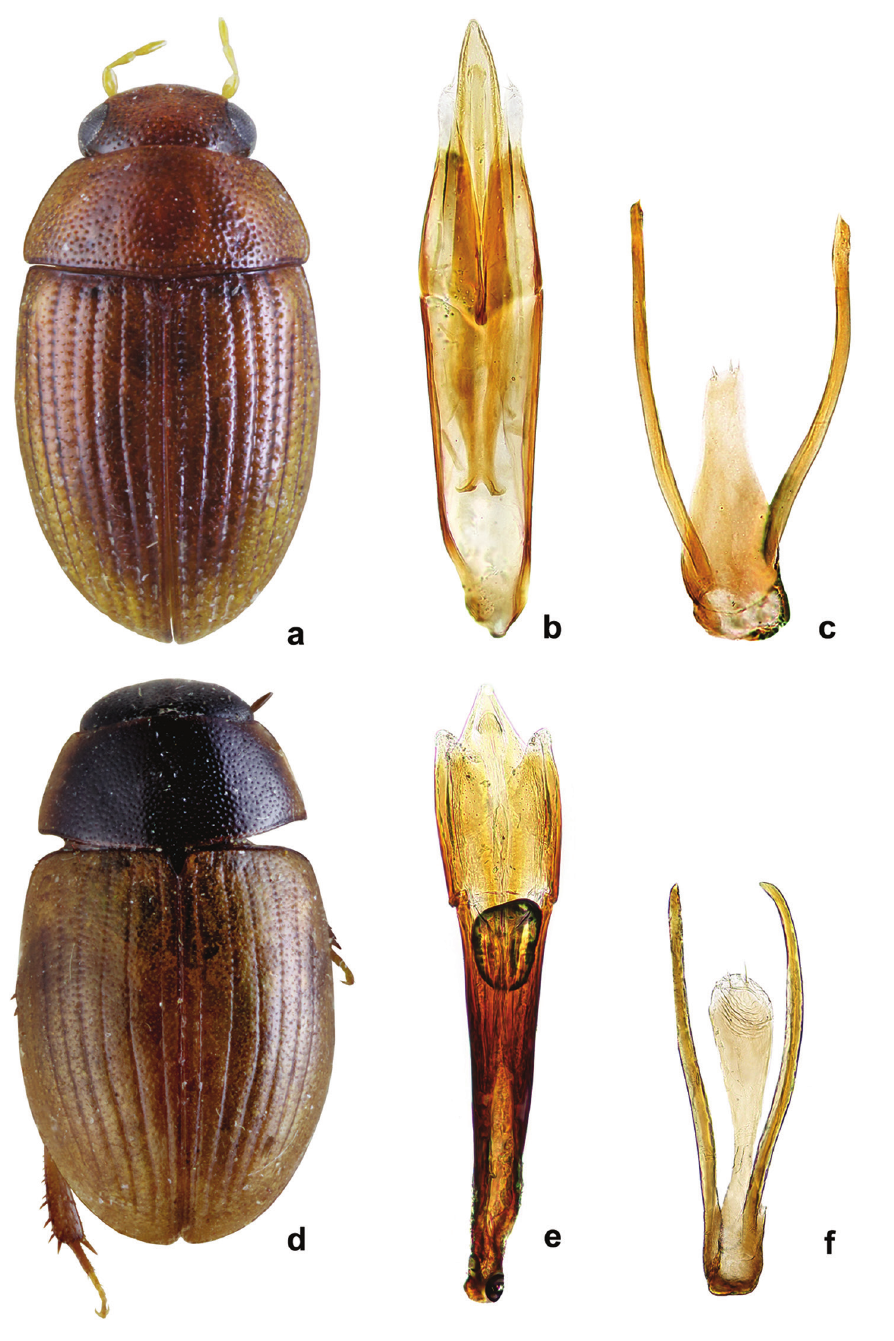
Figure 6. Cercyon (Acycreon) spp. a–c Cercyon (Acycreon) punctiger Knisch: a dorsal habitus b aedeagus c 9 th sternite d–f Cercyon (Acycreon) collarti d’Orchymont paratype: d dorsal habitus e aedeagus f 9 th